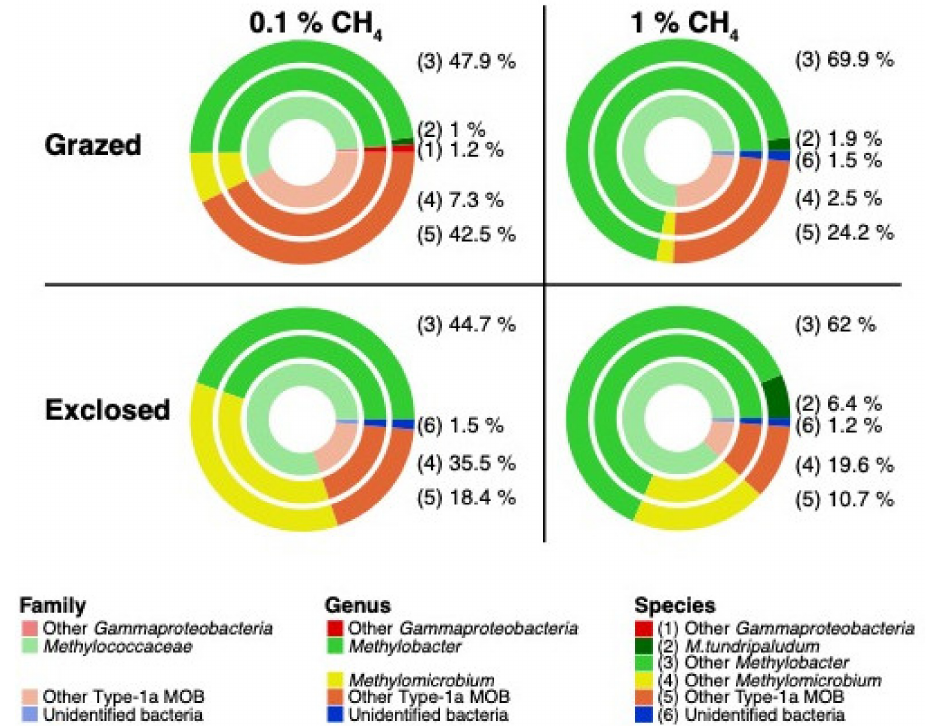
Figure 6. Distribution of MOB taxa (A189F/mb661R primer set) in grazed and exclosed peat soils after incubation at 0.1% CH 4 and at 1% CH 4 (16 soil samples per concentration and 16 soil samples per grazing condition). As temperature had no significant effect on the MOB community, these 16 samples include both the 8 and 15 ◦ C incubations. OTU clustering was performed using Swarm [54] and taxonomically assigned by using the best alignment between the dominant sequence of each OTU and the database using Ggsearch36 [55]. Taxa with a relative abundance of > 1% are represented at the full taxonomic resolution, whereas those taxa not reaching the 1% threshold were added to their broader taxonomic group, one level lower in taxonomic resolution. The different rings represent different taxonomic levels from family to genus to species, moving from the innermost ring outward. Relative abundances for the species level are given in